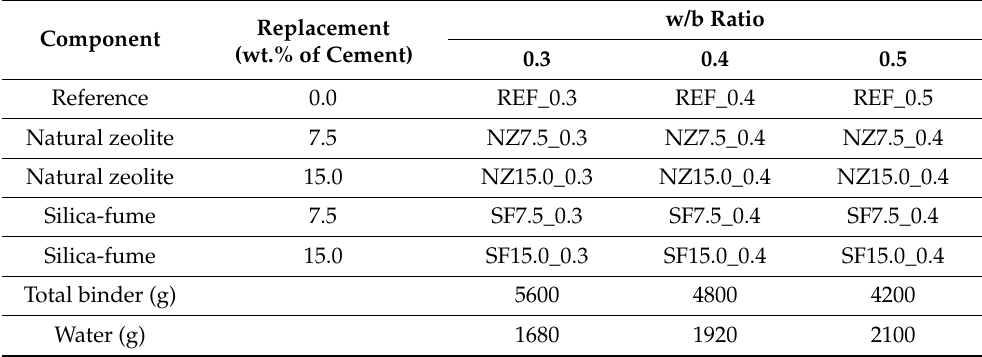
Table 2. Labeling and compositions of the prepared